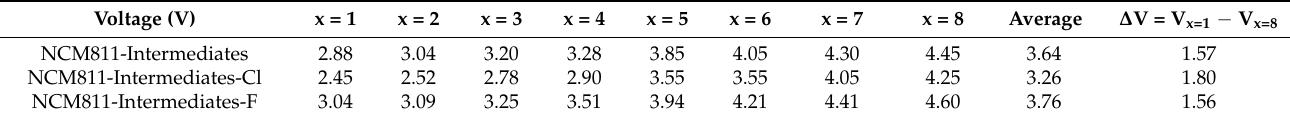
Table 2. Delithiation potential in the process of